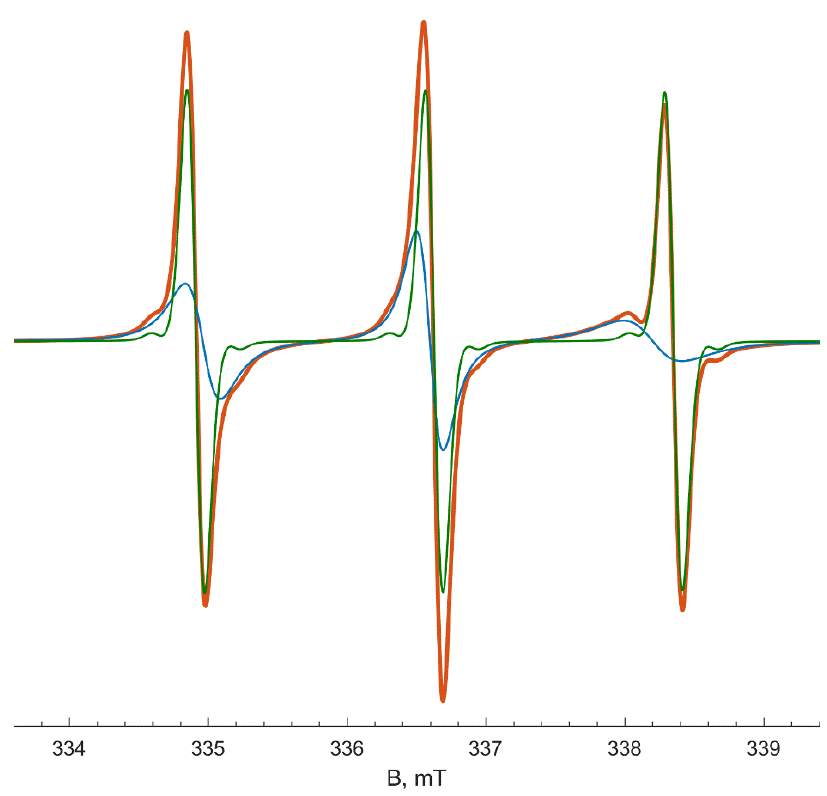
Figure 4. Decomposition of fitted EPR spectrum (red) of TEMPO radical in 10 wt % PNIPAM solution at 333 K into two signals: type A radicals (green) and type B radicals (blue).